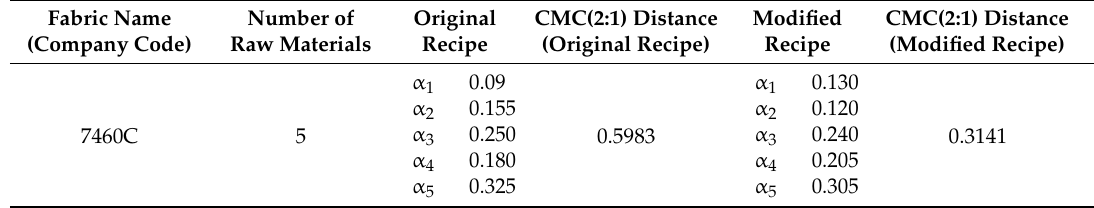
Table 1. Composition and characteristics of the fabric used for reference.